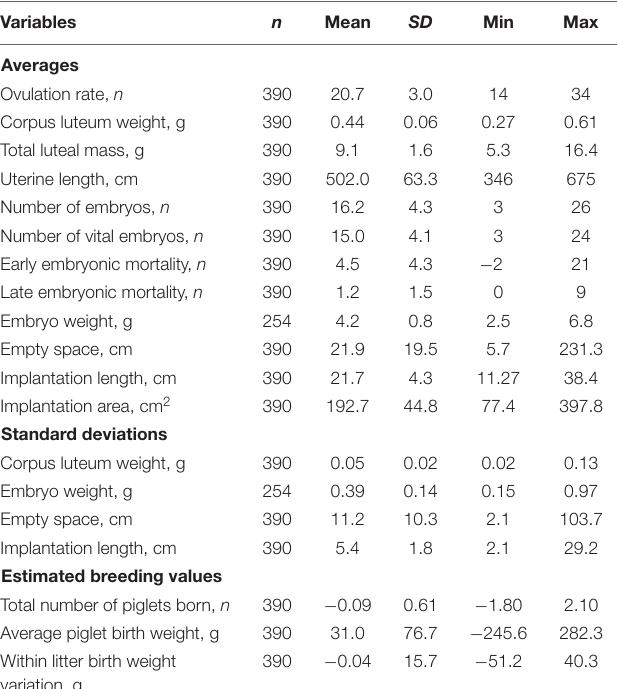
TABLE 1 | Summary statistics of phenotypic traits (ovarian, uterine, and embryonic characteristics) and of the estimated breeding values (EBV) of litter traits of gilts at 35 days of